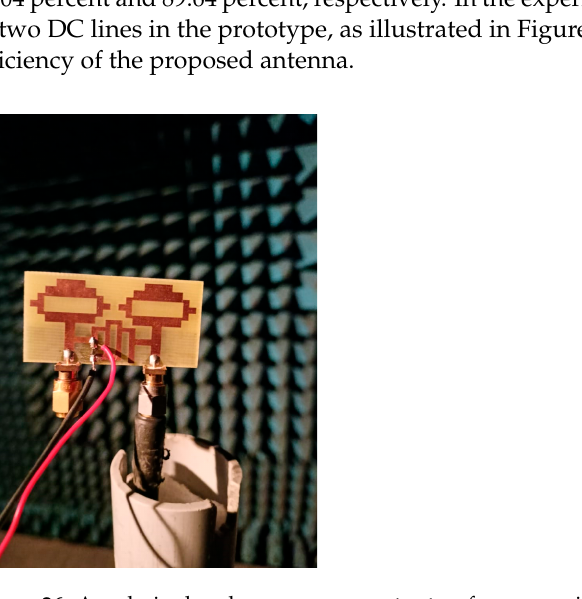
Figure 27. Peak gain and radiation efficiency in both modes. In the simulation and measurement platform, the radiation pattern of the proposed reconfigurable MIMO antenna was observed for both modes, as shown in Figures 28 and 29 with E-plane and H-plane co-polarization and cross-polarization, respectively. The dif- ferences between the maximum and minimum gain from both radiation patterns for the azimuthal plane at both frequencies are greater than 10 dB. The differences in radiation patterns observed between simulation and measured results could be attributed to the influence of biasing circuitry in the prototype model during measurements. Nonetheless, it ensures adequate radiated power for the surrounding region for both frequency bands.